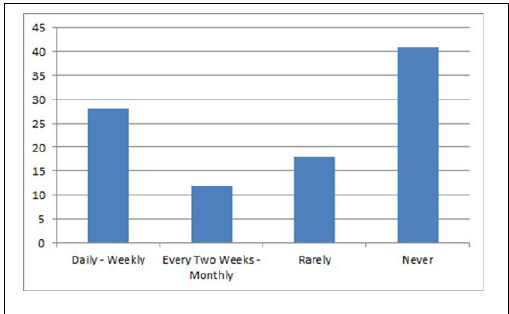
Figure 1: Frequency of students using social media to organise face-to-face meetings with peers from their higher educational community (n=99)